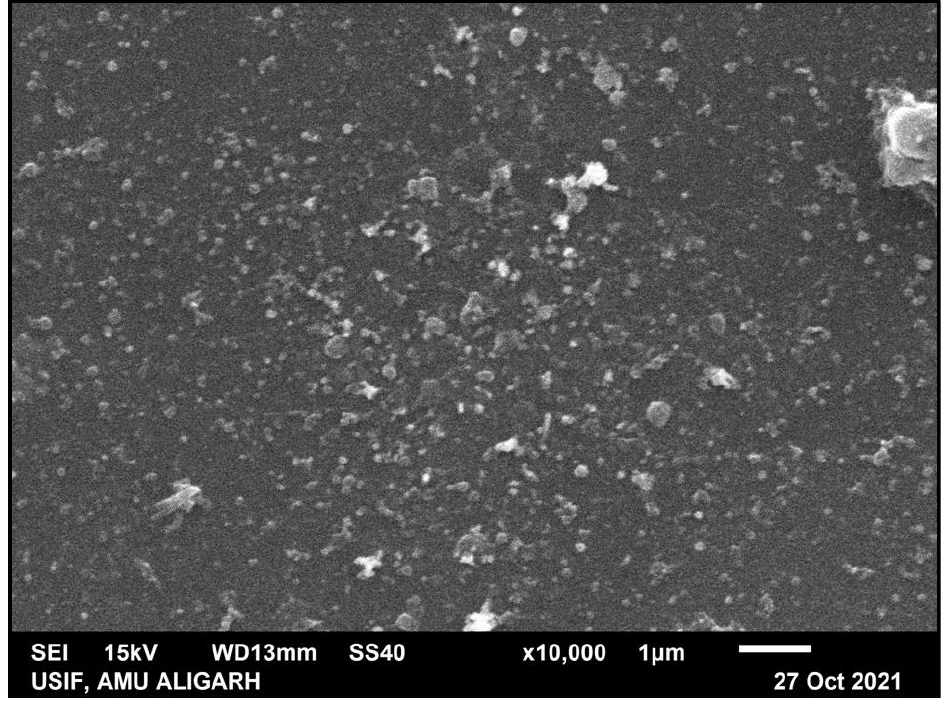
Figure 3. Representation of scanning electron microscopy (SEM) of CS-AgNPs.